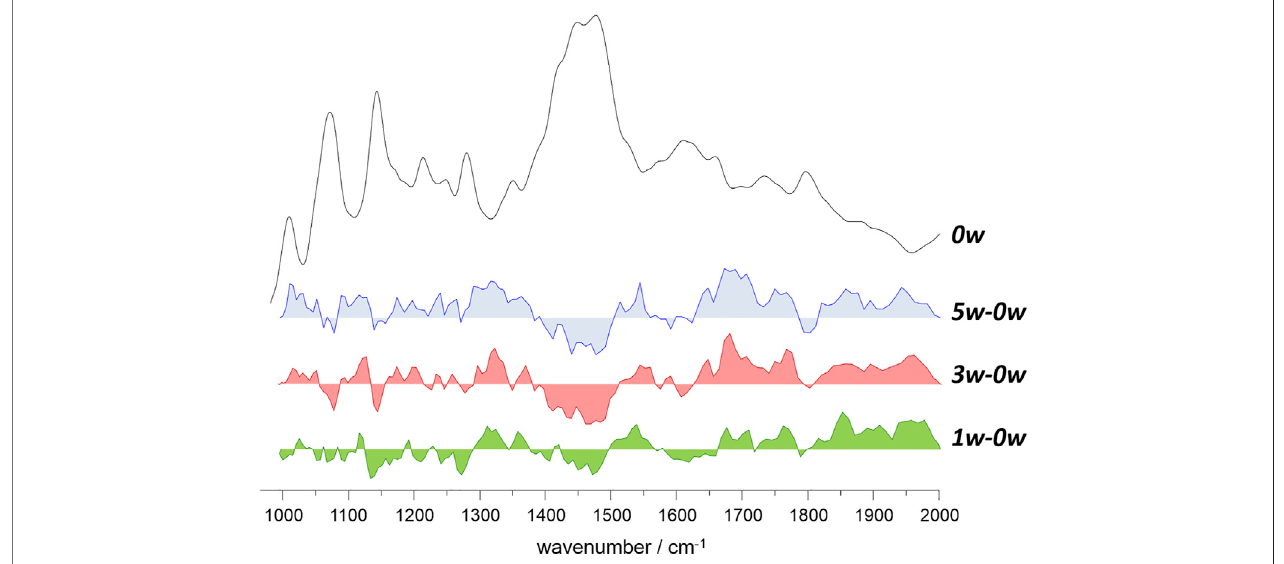
FIGURE 5 | INS spectra of ChCl:urea mixture: the difference spectra ( wet minus dry ) for the DES:water molar ratio of 1:1 (1w-0w), 1:3 (3w-0w), and 1:5 (5w-0w), compared with the spectrum of the dry sample (0w).